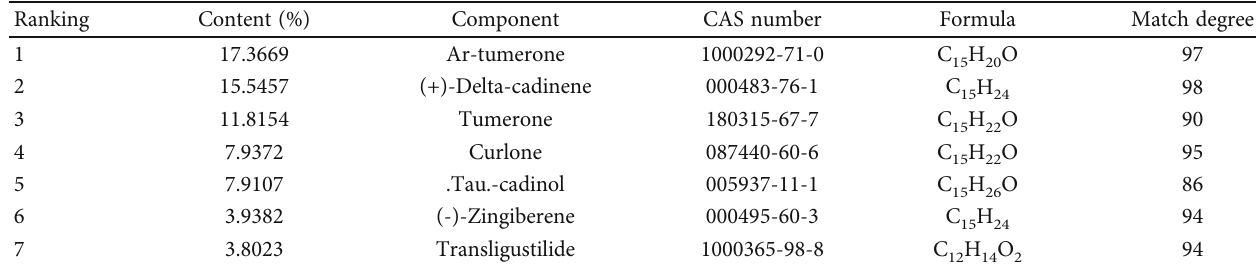
Figure 2: Composition Identi fi cation of SP-EOs and SP-NEs. (a) Visual features of SP-EOs and SP-NEs. (b) GS-MS chromatogram of SP- EOs and SP-NEs. Table 2: Major chemical composition of SP-EOs.